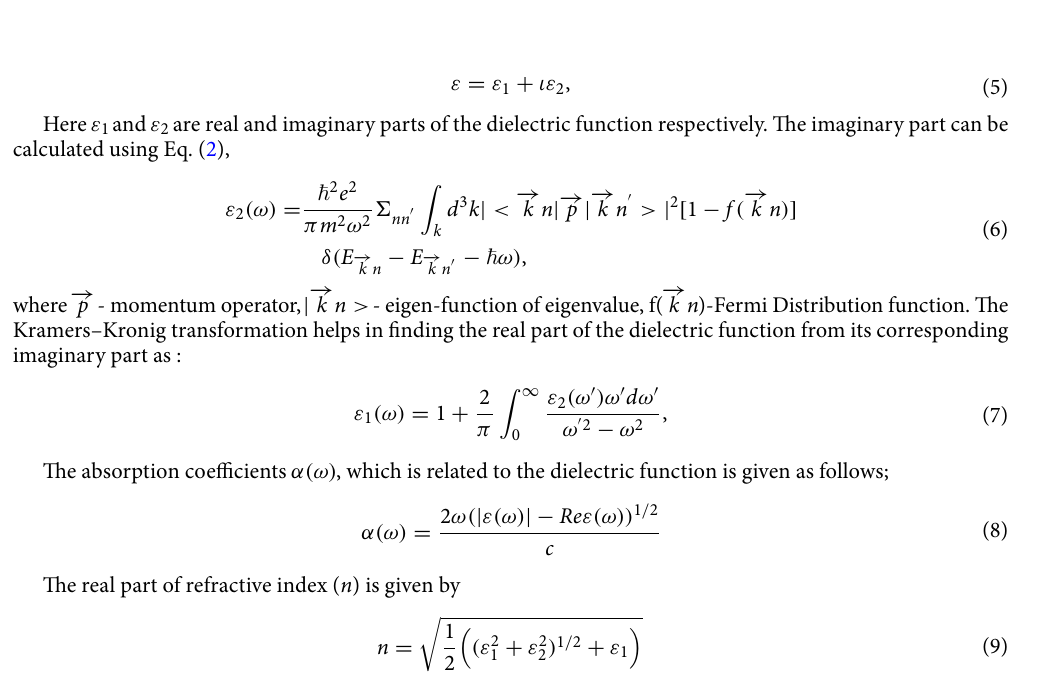
Figure 6. The variation of energy bandgap (E g ) as a function of slab thickness (t) of 001-surface of CrPbBr 3 using DFT-1/2 (blue line represent the results of energy bandgap and red dot denotes the data fit using Eq. (4) from